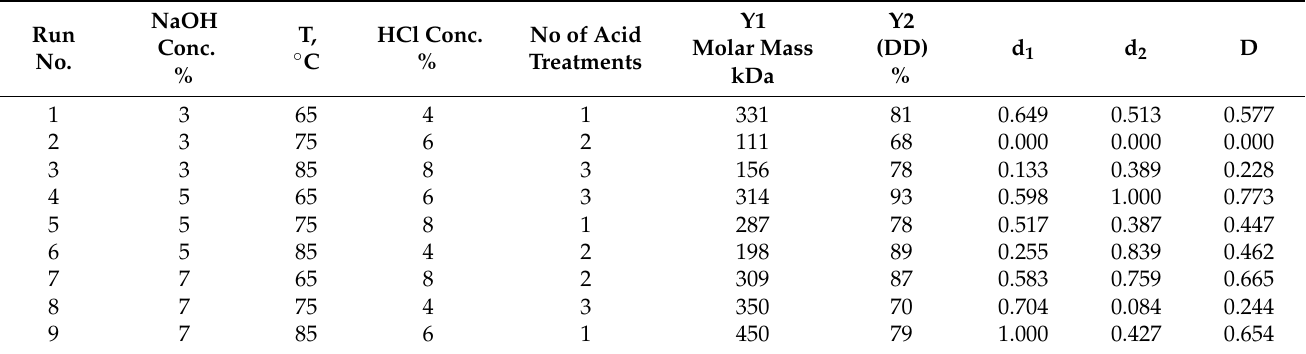
Table 3. Individual and global desirability for maximum deacetylation degree and maximum mo- lar mass.